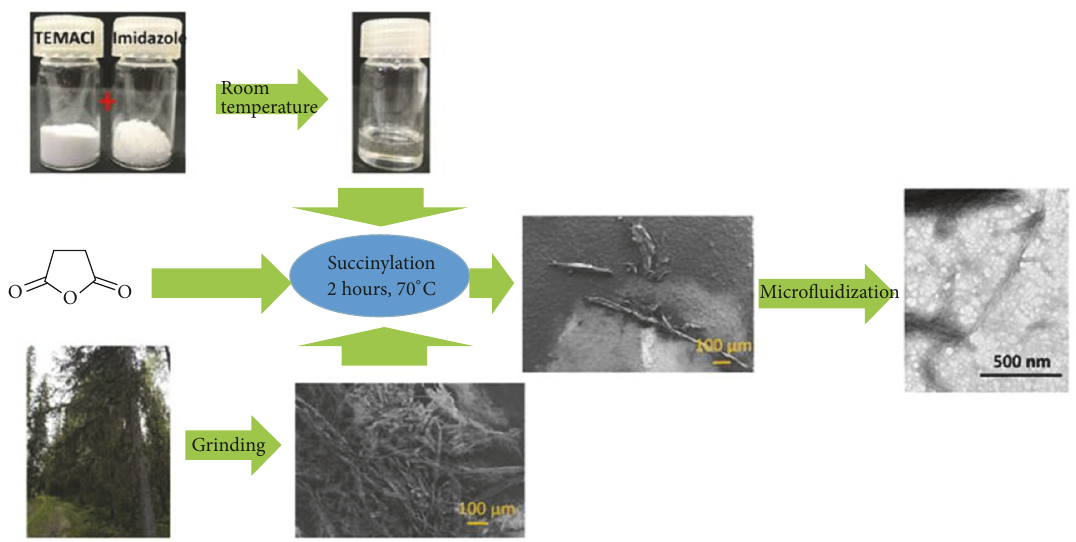
Figure 16: Schematic diagram of DES pretreatment for the preparation of anionic CNFs